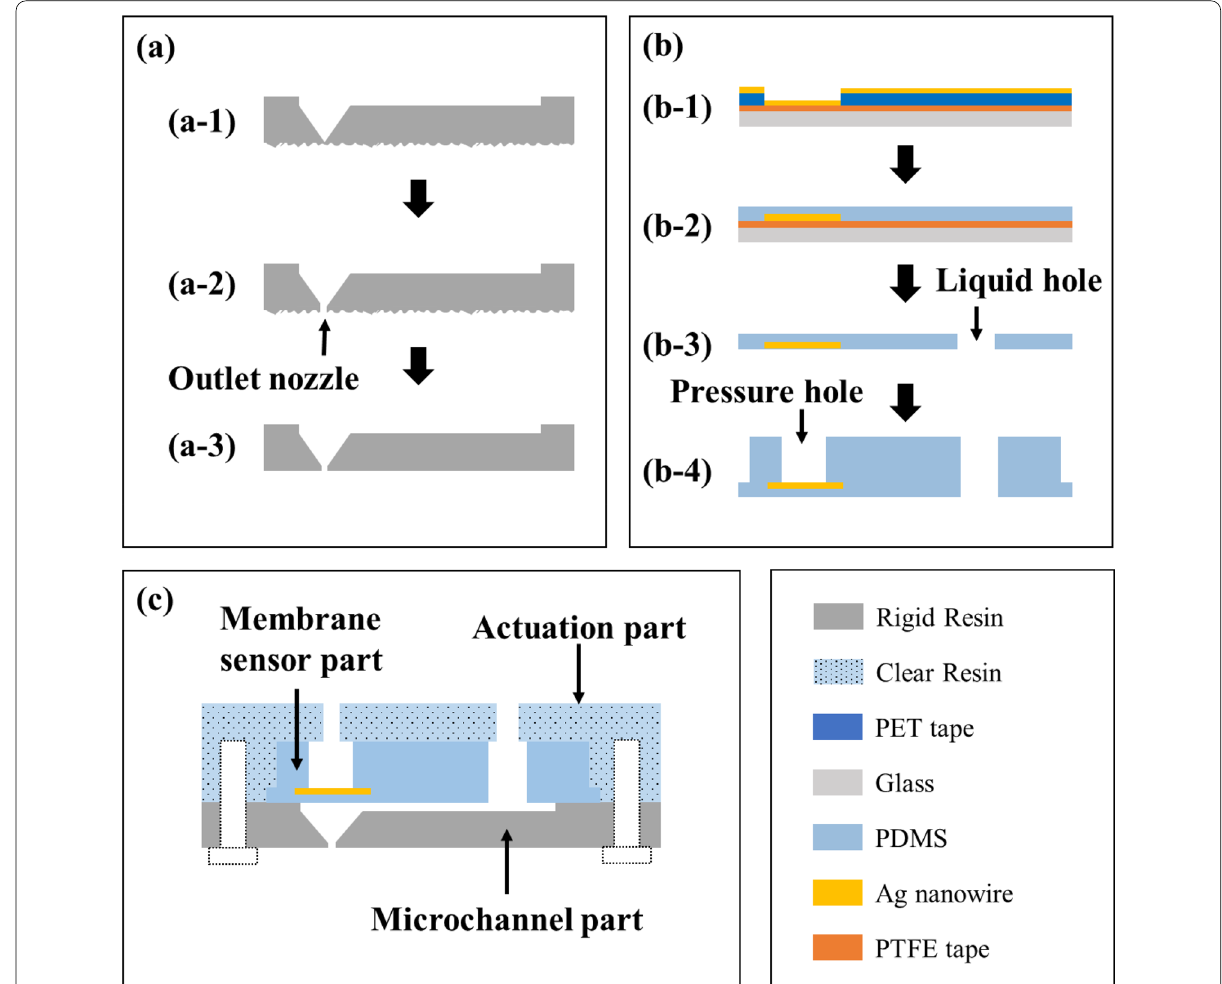
Fig. 2 Fabrication process of a pneumatic dispenser; a microchannel, b membrane sensor, and c assembled